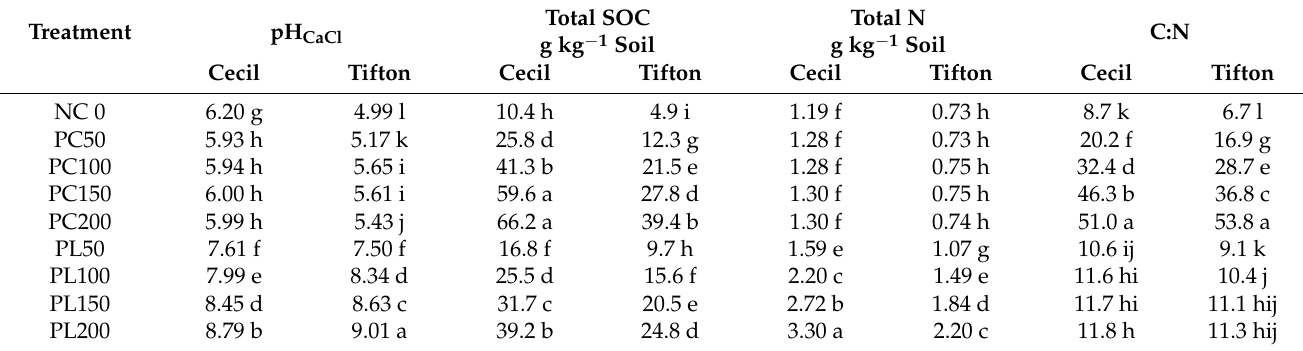
Table 3. Means of soil properties showing significant differences among treatments and soils for significant soil*treatment